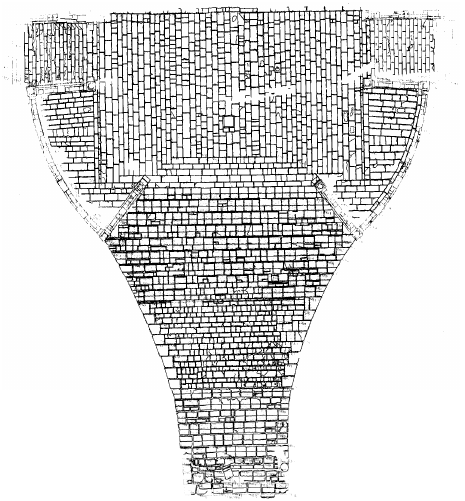
Figure 8. Photogrammetry of the Cais das Colunas, Lisbon. General restitution made during the dismantling (Genin,